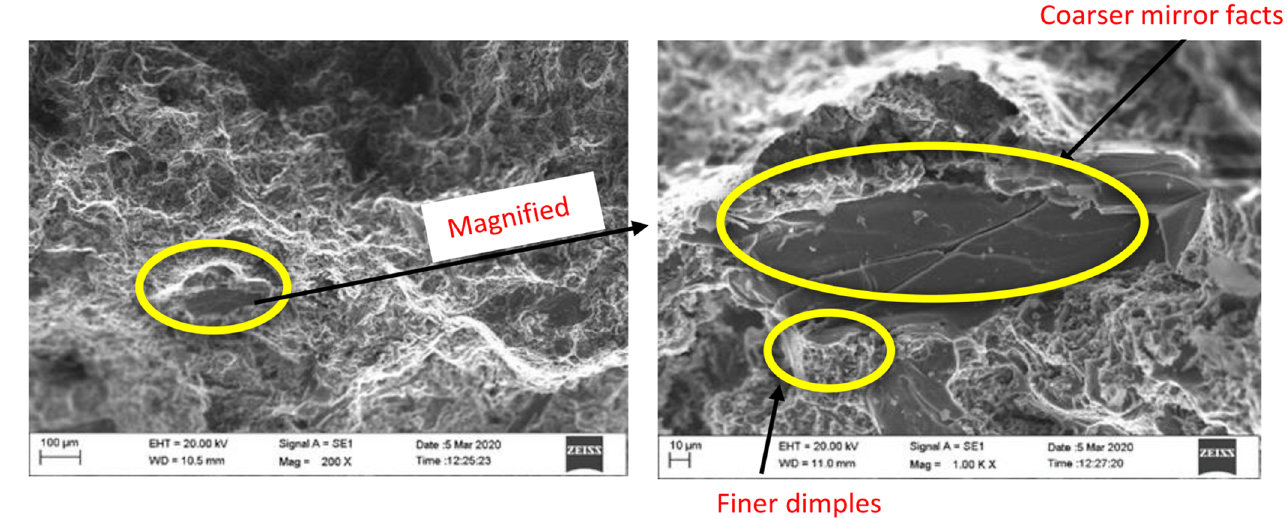
Fig. 16. SEM micrographs of fractured surface of